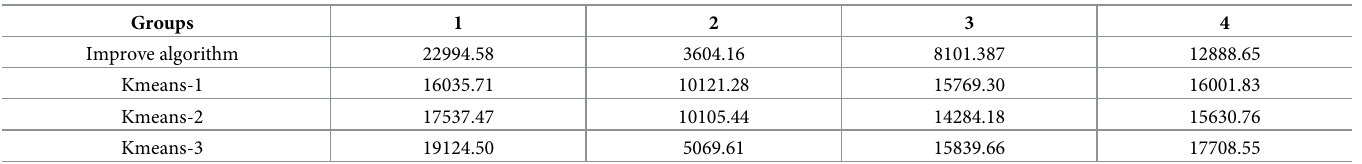
Table 3. Comparison of within-group error sum of squares.